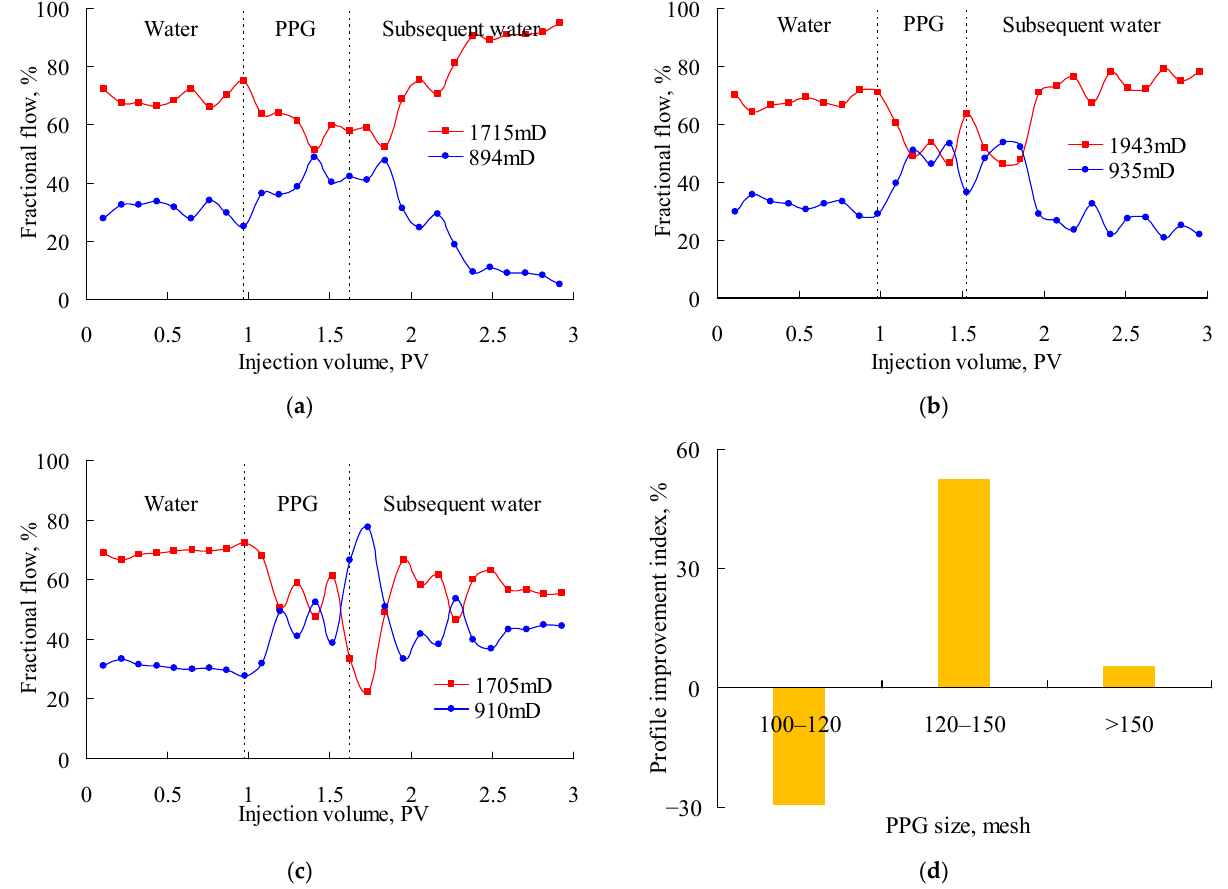
Figure 4. Fractional flow of parallel sand packs with permeability ratio of about 2 after injecting the PPG (2–4 Pa). ( a ) 100–120 mesh; ( b ) 150–180 mesh; ( c ) 120–150 mesh; ( d ) profile improvement index.